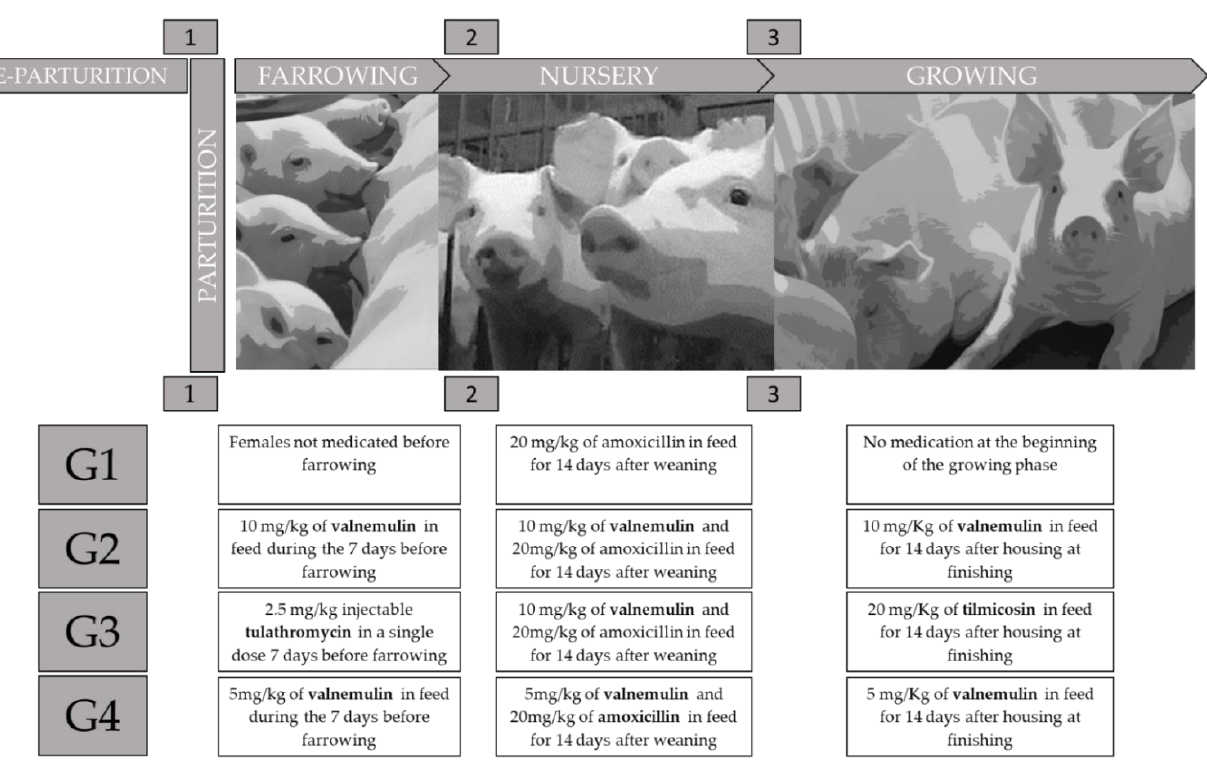
Figure 4. Schematics of medication protocols used in animals from G1 to G4.